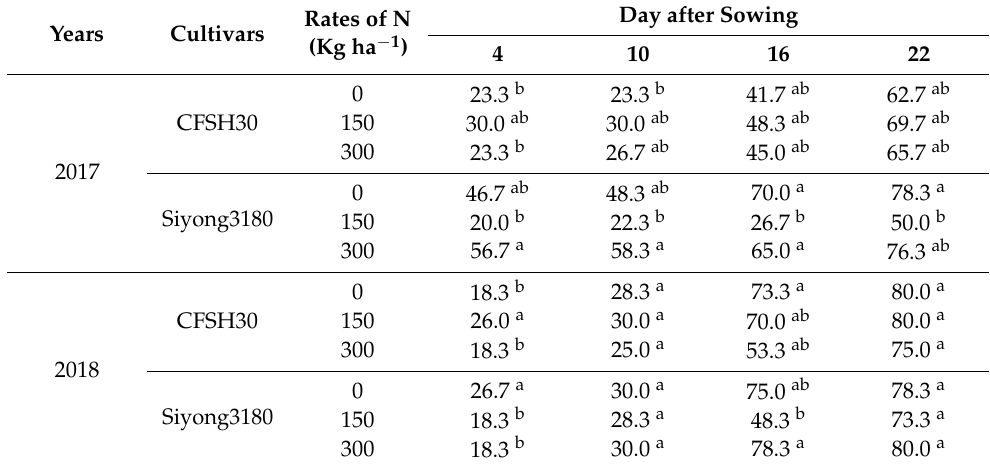
Table 2. Effects of N rates on sorghum germination% with two sorghum varieties, during 2017 and 2018.